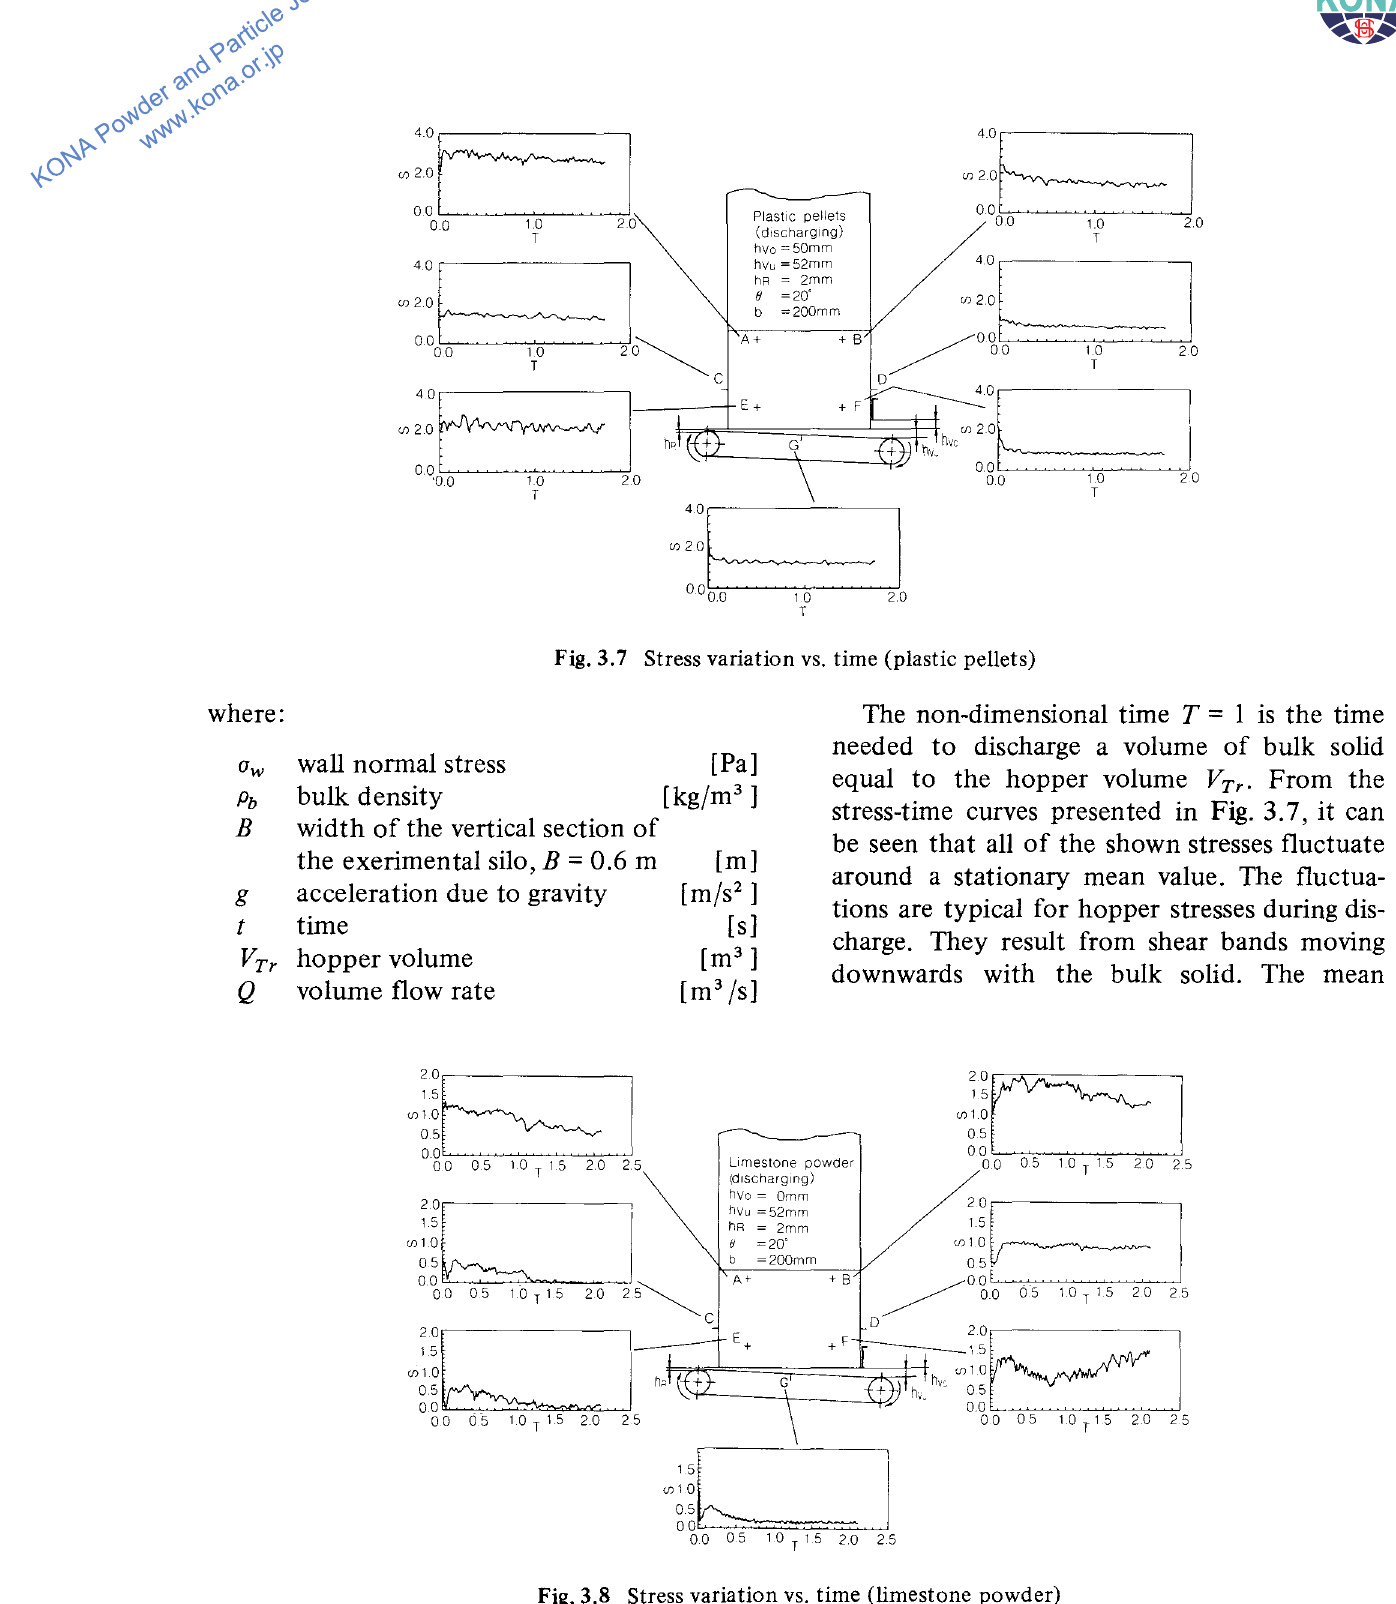
Fig. 3.8 Stress variation vs. time (limestone